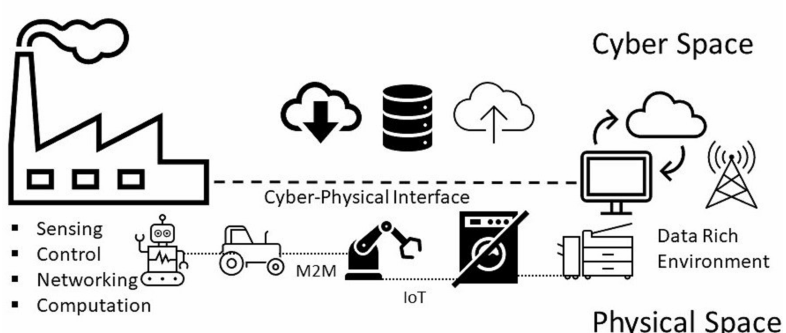
Figure 3. Cyber Manufacturing Systems